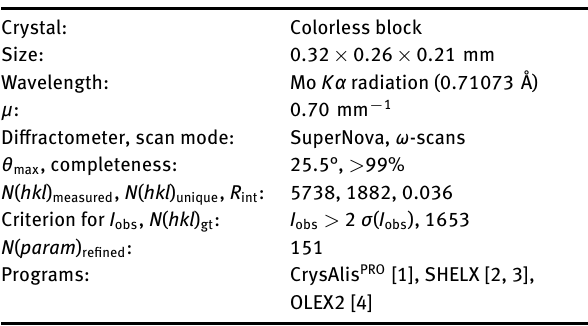
Table 2: Fractional atomic coordinates and isotropic or equivalent isotropic displacement parameters (Å 2